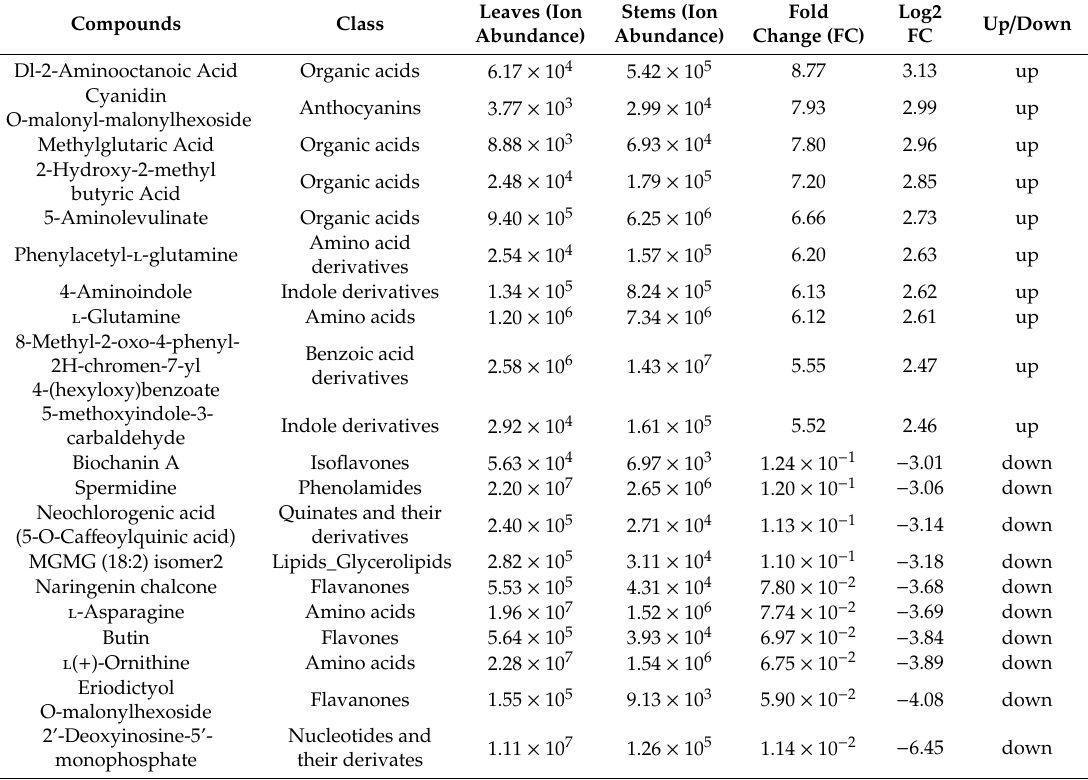
Table 2. Top 10 up and down accumulated metabolites in the stems as compared to the